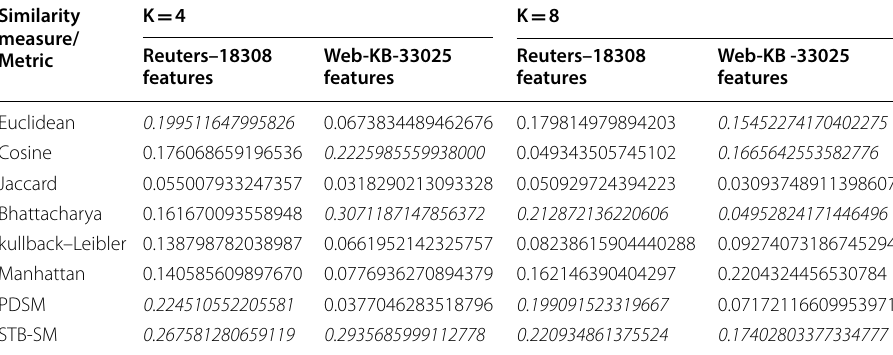
Italic values indicate the highest values that top measures achieved for corresponding evaluation metrics